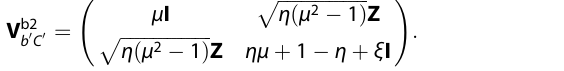
ffiffiffiffiffiffiffiffiffiffiffiffiffiffiffiffiffiffiffiffi